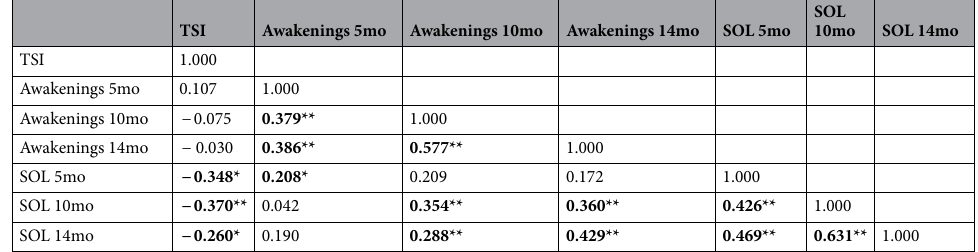
Table 2. Correlation coefficients (Spearman) of all measures used in the analyses. *Significant correlation p < .05 (2-tailed). **Significant correlation p < .01 (2-tailed). SOL Sleep Onset Latency, mo months. Significant values are in